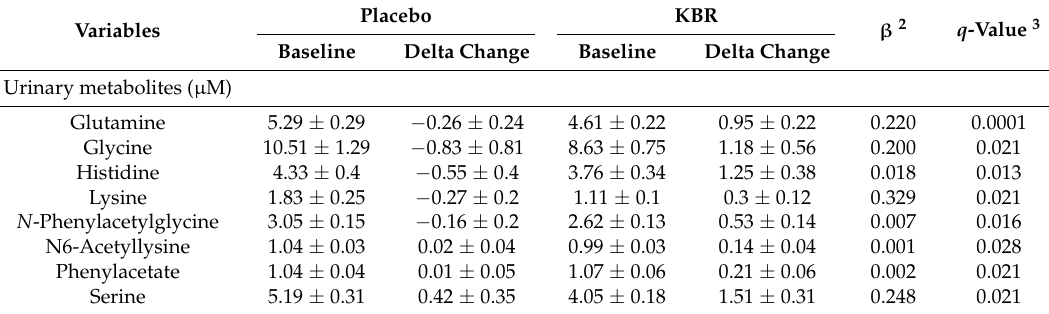
Figure 1. Proposed metabolic pathways related to endogenous urinary metabolites that were significantly changed in response to KBR administration over four weeks compared with those in the placebo group. Arrows indicate the directions of alterations. KBR, Korean black raspberry.